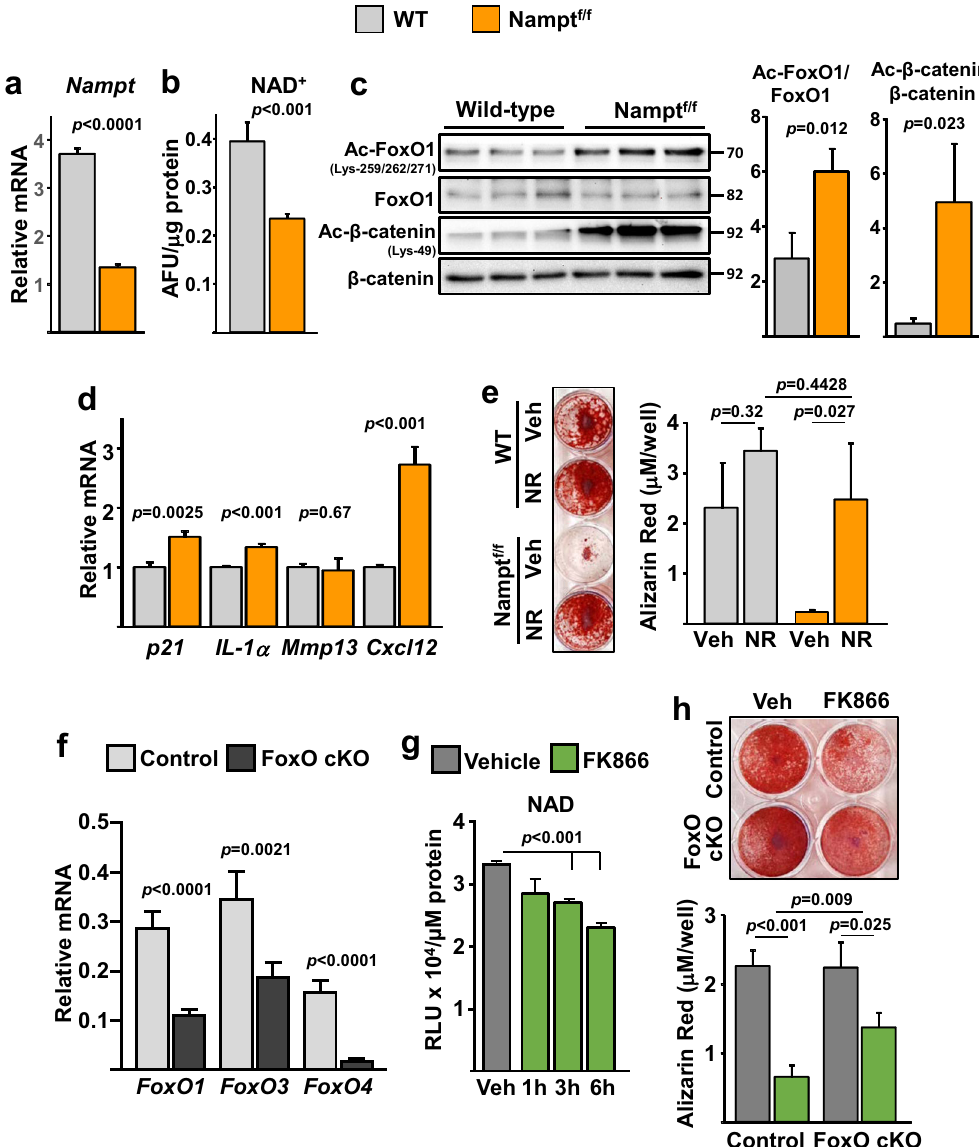
Fig. 6 Inhibition of Nampt promotes FoxO and β -catenin acetylation and decreases osteoblastogenesis. a – e Bone marrow stromal cells from WT or Nampt f/f mice, infected with Ad-Cre and cultured under osteogenic conditions for 5 days. a mRNA expression by qRT-PCR. b Relative cellular NAD + levels. AFU arbitrary fl uorescence units. c Protein levels by western blot. Each band represents one mouse. d mRNA expression by qRT-PCR. e Representative images (left) and quanti fi cation of Alizarin Red staining (right) of bone marrow stromal cells, described in a , cultured under osteogenic conditions for 21 days. f mRNA expression in bone marrow stromal cells from 3-month-old control (FoxO1,3,4 f/f ) or cKO (FoxO1,3,4 Δ Osx1-Cre ) littermate mice cultured under osteogenic conditions for 5 days. g Time-dependent effects of 10 µM FK866 on NAD levels in bone marrow cells from 6-month-old C57BL/6 female mice. h Representative images (top) and quanti fi cation of Alizarin Red staining (bottom) of bone marrow stromal cells described in f , cultured under osteogenic conditions without or with 10 µM FK866 for 21 days. In all experiments except c , data were obtained from triplicate cultures from cells pooled from three mice per group. Data represent mean ± SD; p values by two-tailed t -test ( a – d , f ), one-way ANOVA ( g ), or two-way ANOVA ( h